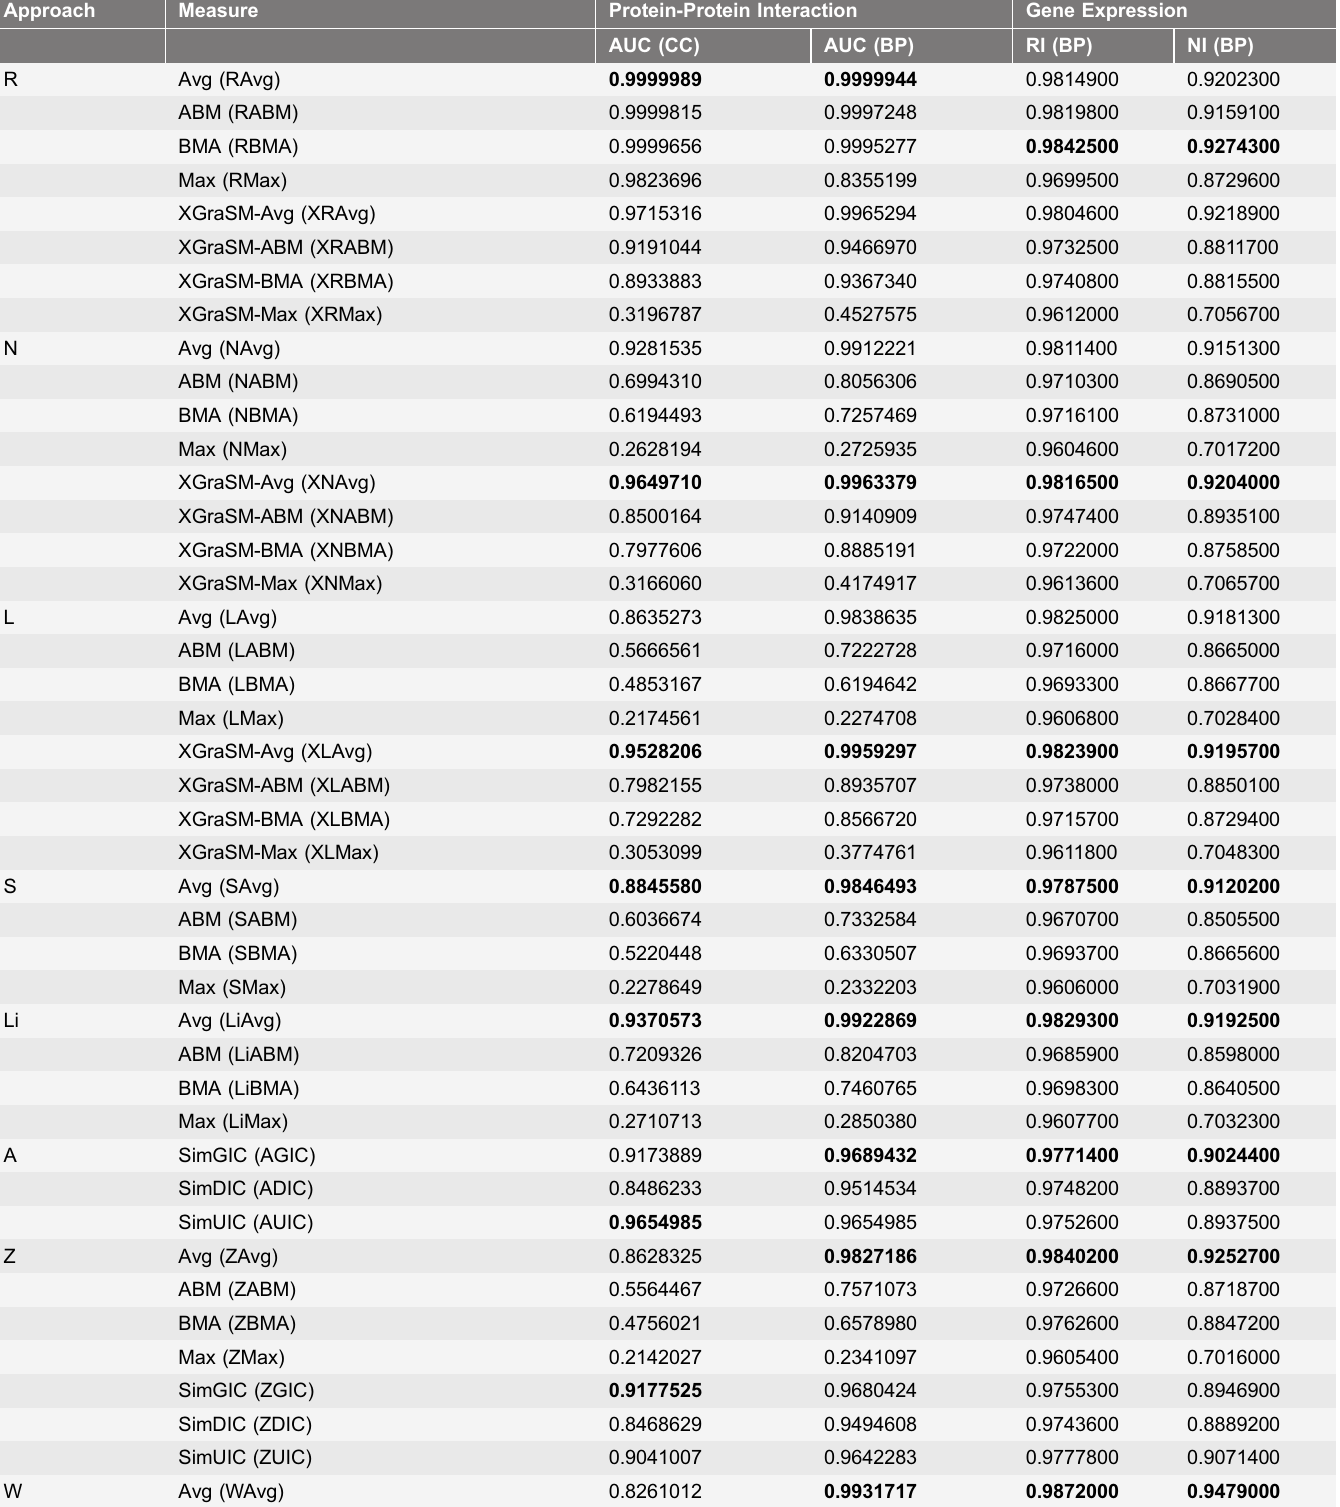
Table 3. Area under the curve (AUC), Rand Index (RI) and Normalized Mutual Information (NI) values of different measures.